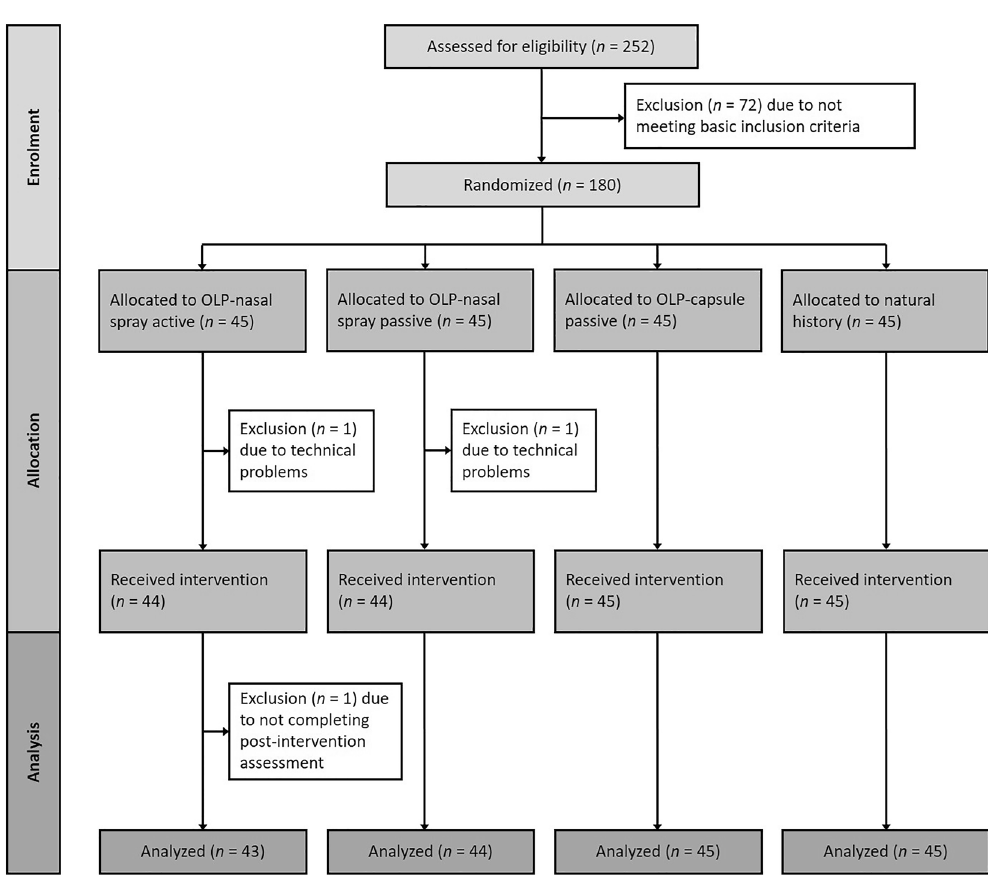
Figure 1. Participant flow